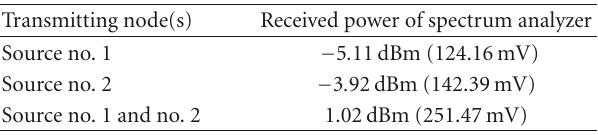
Table 1: Experiment